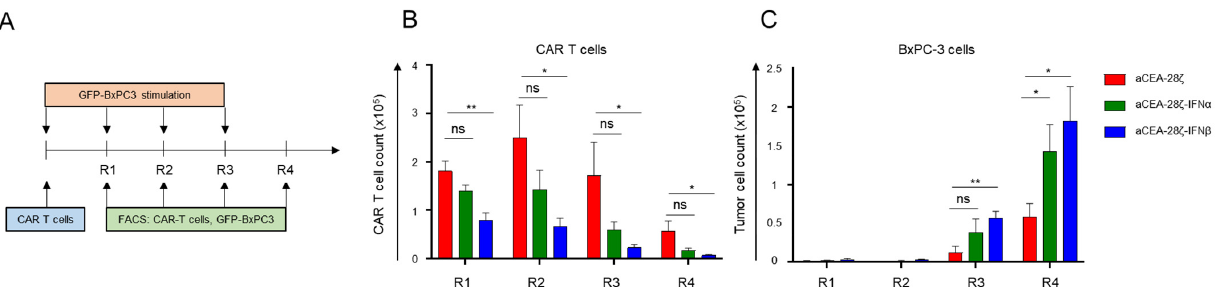
Figure 3. Self-limiting activity and persistence of IFN-CAR T-cells. ( A ) Experimental design of the repetitive antigen-stimulation assay. CAR T-cells (starting with 1 × 10 5 CAR T-cells) with and without IFN payload were subjected to four rounds (R1–R4) of antigen-stimulation with GFP-labeled CEA+ BxPC-3 cells (1 × 10 5 tumor cells at start of each round). At the end of each round, CAR T-cells (live CD3+/CAR+) ( B ) and BxPC-3 cells (live GFP+ tumor cells) ( C ) were counted by flow cytometry using counting beads. ( B , C ) Data represent means ± SEM of nine T-cell donors, p values were calculated by Student’s t test, ns indicates not significant * indicates p ≤ 0.05, ** indicates p ≤ 0.01.